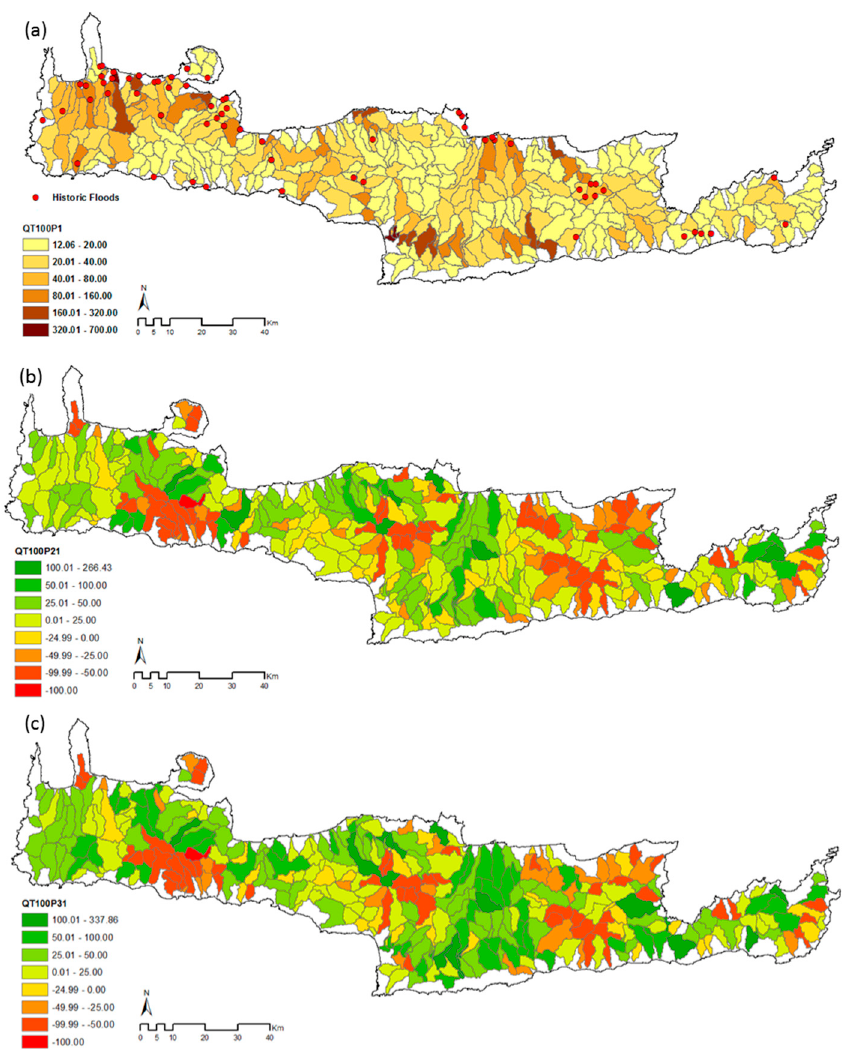
Figure 7. Flow frequency analysis under climate change using GEV distribution for T = 100 years return period and for study periods ( a ) 1985–2010 (baseline period), ( b ) 2025–2050 (relative percentage change), ( c ) 2075–2100 (relative percentage change).